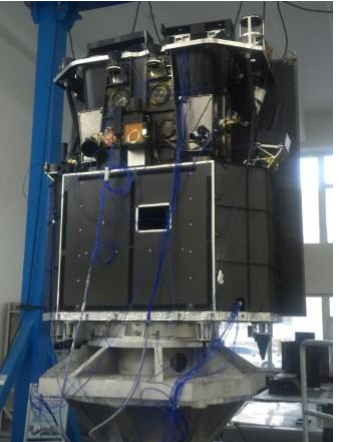
Figure 6. The lift-off vibration test of the satellite.